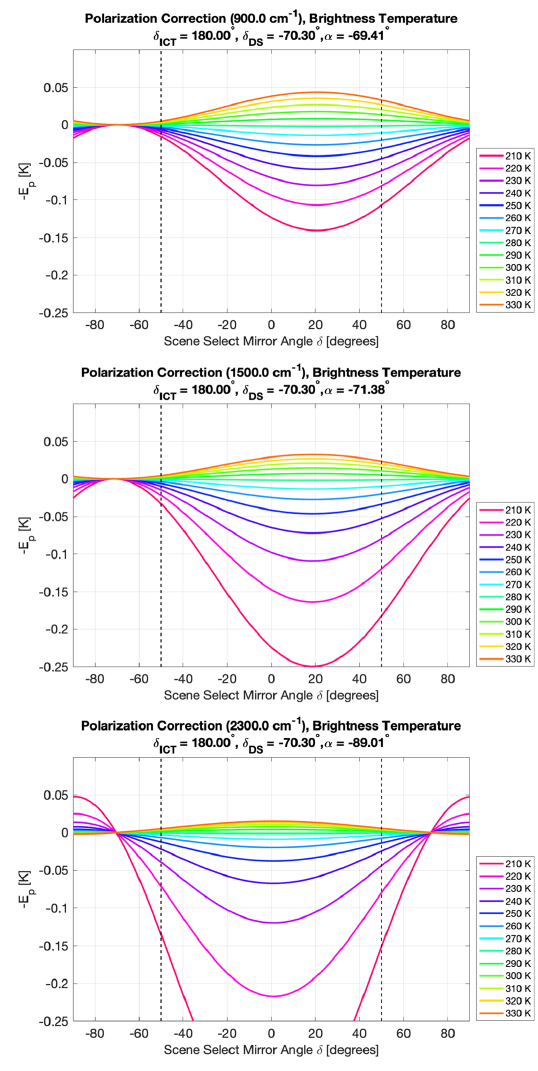
Figure 17. Calculated polarization correction at 900 cm − 1 ( top panel ), 1500 cm − 1 ( middle panel ), 2300 cm − 1 ( bottom panel ) as a function of scene brightness temperature and scene select mirror angle. The NOAA-20 CrIS pitch maneuver derived values have been used for the scene select mirror and instrument polarization and sensor polarization angle. The vertical dashed lines indicate the angu- lar extent of the CrIS cross-track scan of the Earth.